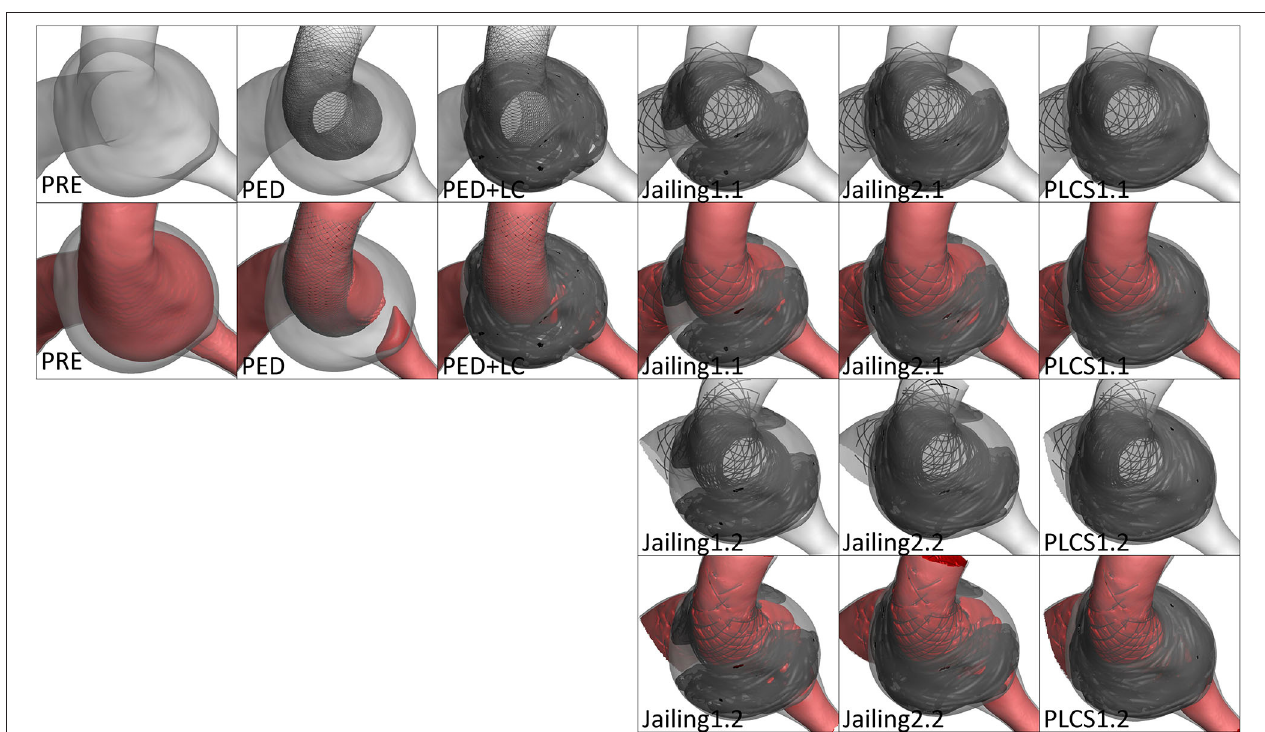
FIGURE 5 | The down-the-barrel view of preoperative and different stent-assisted technique simulation treatment.